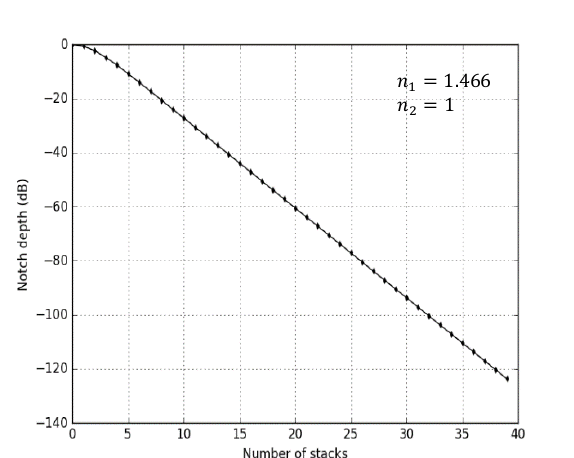
FIG. 4. Variation of notch depth as a function of the total number of stacks